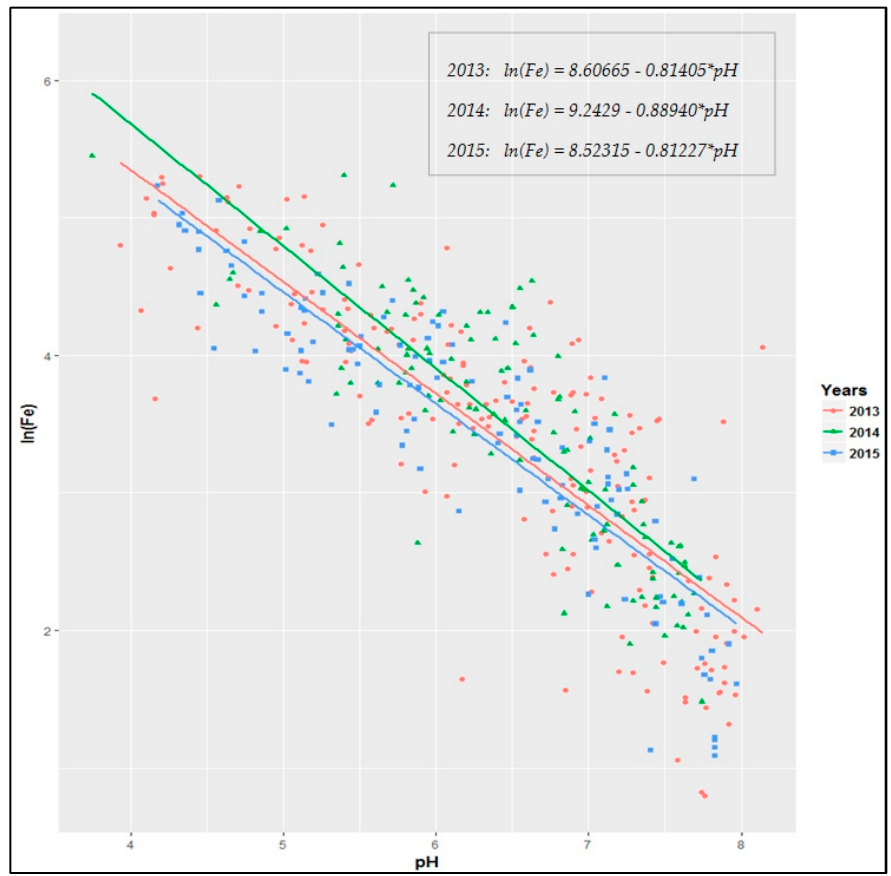
Figure 6. Regression lines and functions between soil ln(Fe) and pH for each year.